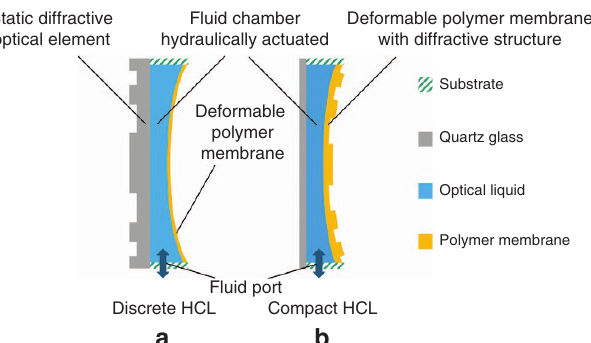
Figure 1 Schematic diagrams of the two hyperchromatic lens concepts: ( a ) the ‘ discrete HCL ’ with separate hydraulically-actuated refractive and fi xed diffractive components; and ( b ) the ‘ compact HCL ’ , for which the diffractive structure is etched onto the fl exible refractive membrane. The curvatures of the refractive lenses are deformed by changing the pressure on an optical liquid in the lens chamber, thus tuning the focal length of hyperchromatic lenses.